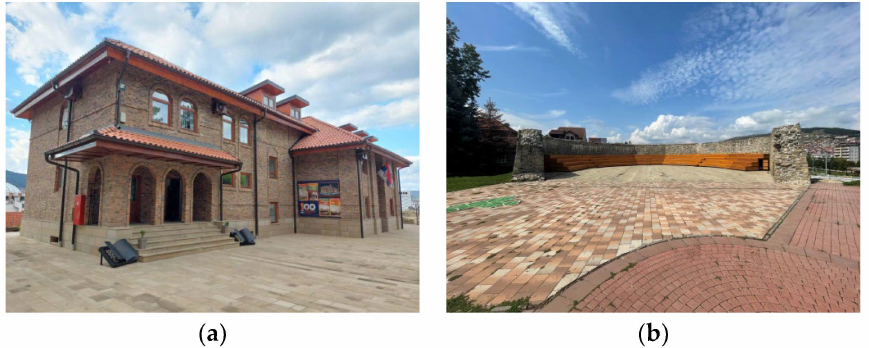
Figure 26. Interventions at the city fortress: ( a ) City library in the area of the fortress (Photo source: Branko Slavkovi´c); ( b ) summer stage on western Tabia (Photo source: Lejla